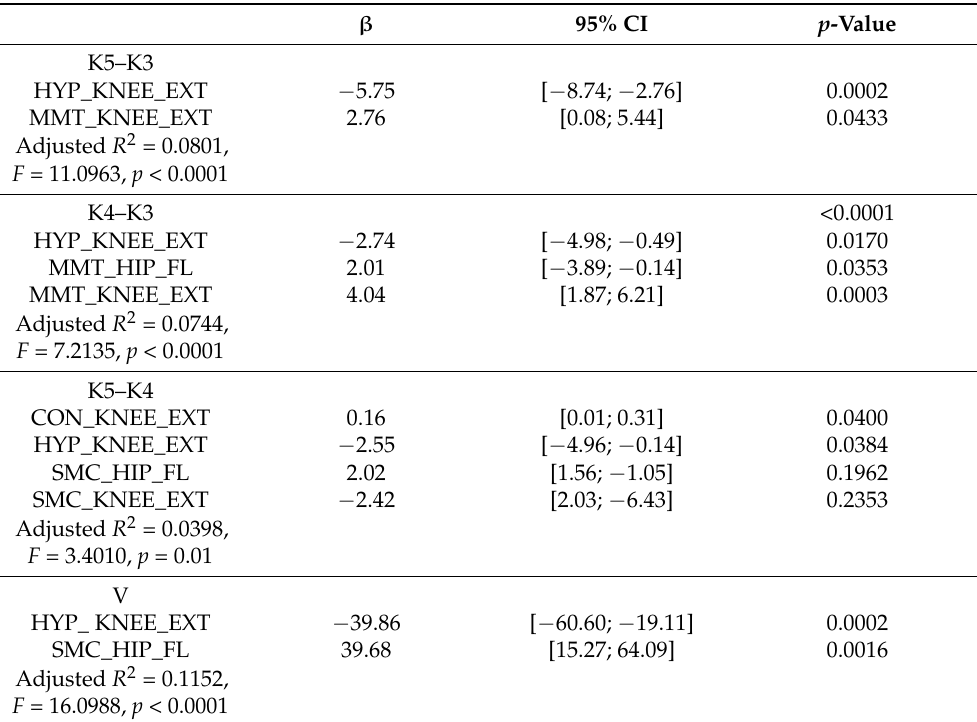
Table 2. Multiple linear regression analysis with selected knee ROM and angular velocity at toe-off as independent variables ( n = 262).